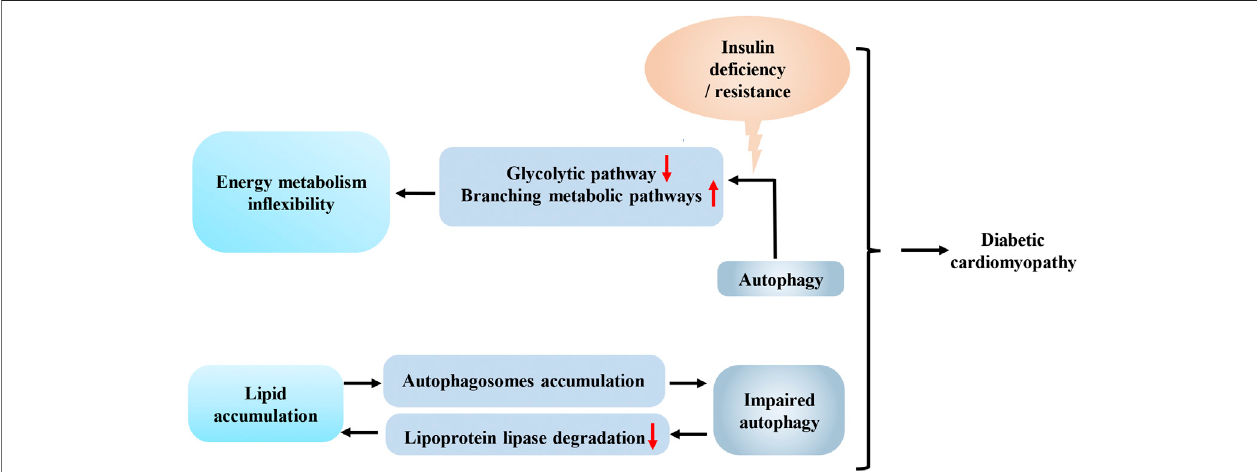
FIGURE 2 | Interaction between autophagy and energy metabolism in diabetes-associated cardiomyopathy. Decreased insulin signal transduction in the heart shiftsglucosefromglycolyticpathwaytobranchingmetabolicpathwaysbyautophagy,whichreducestheef fi ciencyofenergy metabolismandincreasesthecardiac the in fl exibility of cardiac metabolism. Increased lipid deposition can lead to impaired autophagy, which in turn aggravates the accumulation of lipid in the heart. This vicious circle, combined with the in fl exibility of energy metabolism, exacerbates diabetes-associated cardiomyopathy.